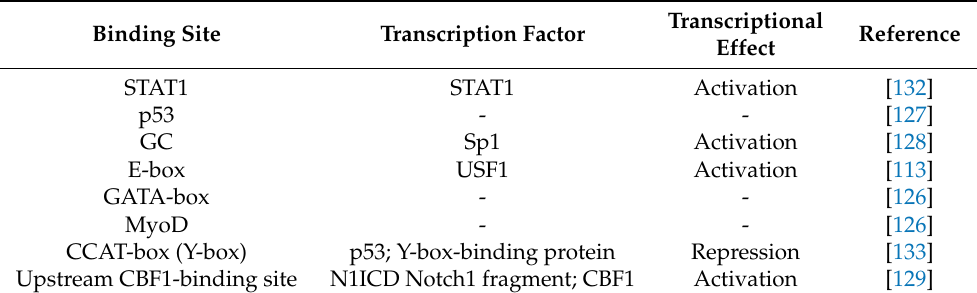
Table 2. Binding sites of transcription factors (from proximal to distal) of human MVP promoter and their transcriptional effects (when